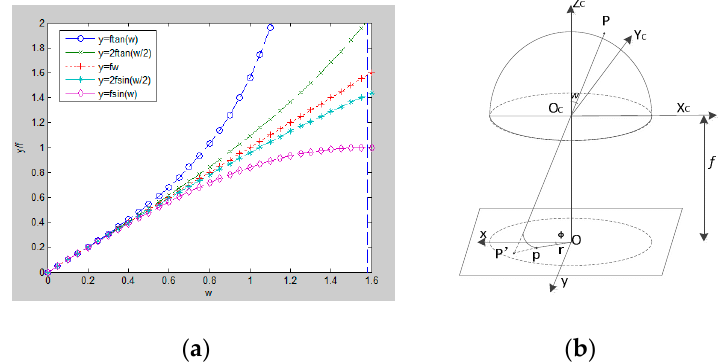
Figure 1. ( a ) Relationship between four imaging formulas and ideal imaging ( b ) Fisheye camera model true lens does not completely follow the projected projection